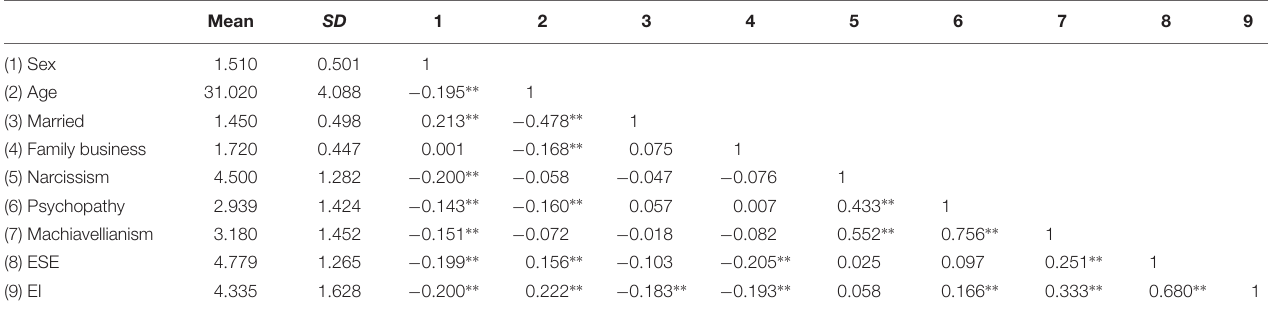
TABLE 2 | Mean, standard deviation, and correlation of study variable. Mean